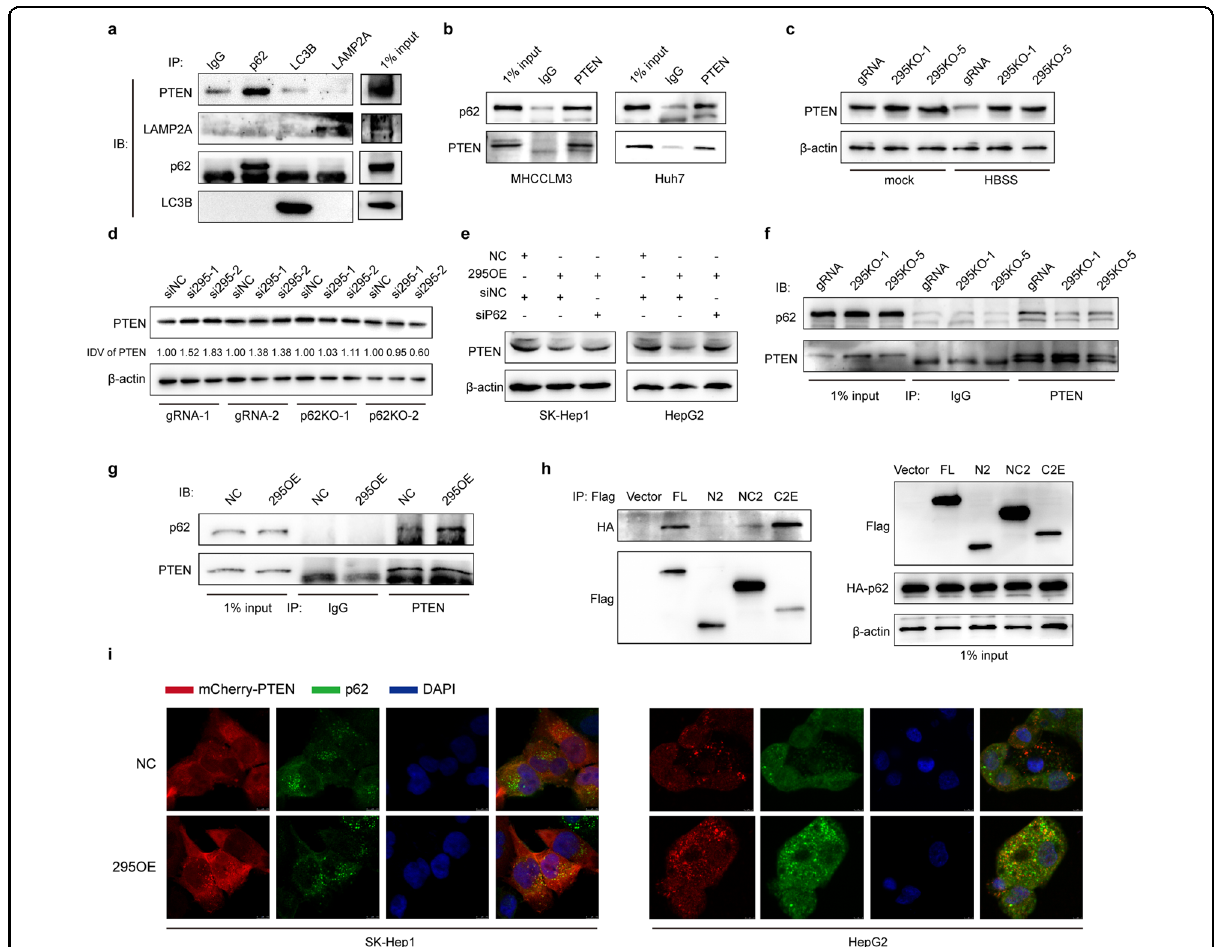
Fig. 5 PTEN interacts with p62, and RP11-295G20.2 is essential for the interaction between PTEN and p62. a The binding of p62, LAMP2A and LC3B with PTEN were examined by coimmunoprecipitation experiments with p62, LAMP2A, and LC3B antibodies. b p62 was co-immunoprecipitated with PTEN by a PTEN antibody. c PTEN degradation induced by HBSS treatment is reversed by RP11-295G20.2 knockout. d , e p62 is crucial for PTEN regulation by RP11-295G20.2. PTEN is upregulated in RP11-295G20.2 knockdown HCC cells but not in p62 knockout HCC cells. Integrated Density Value (IDV) was obtained by ImageJ, normalized to β -actin and siNC ( d ). PTEN is degraded in RP11-295G20.2-overexpressing HCC cells, but its level was restored after p62 knockdown ( e ). f , g RP11-295G20.2 is necessary for the interaction between PTEN and p62. h p62 interacts with the tail domain of the PTEN protein. Truncated PTEN fragments were transfected into HCC cells and the binding of p62 was analyzed by coimmunoprecipitation assays. i p62 and PTEN are colocalized in RP11-295G20.2-overexpressing HCC cells. SK-Hep1 or HepG2 cells were transfected with the mCherry-PTEN vector and stained with an anti-p62 antibody. PTEN puncta are indicated with red dots, and p62 are indicated with green